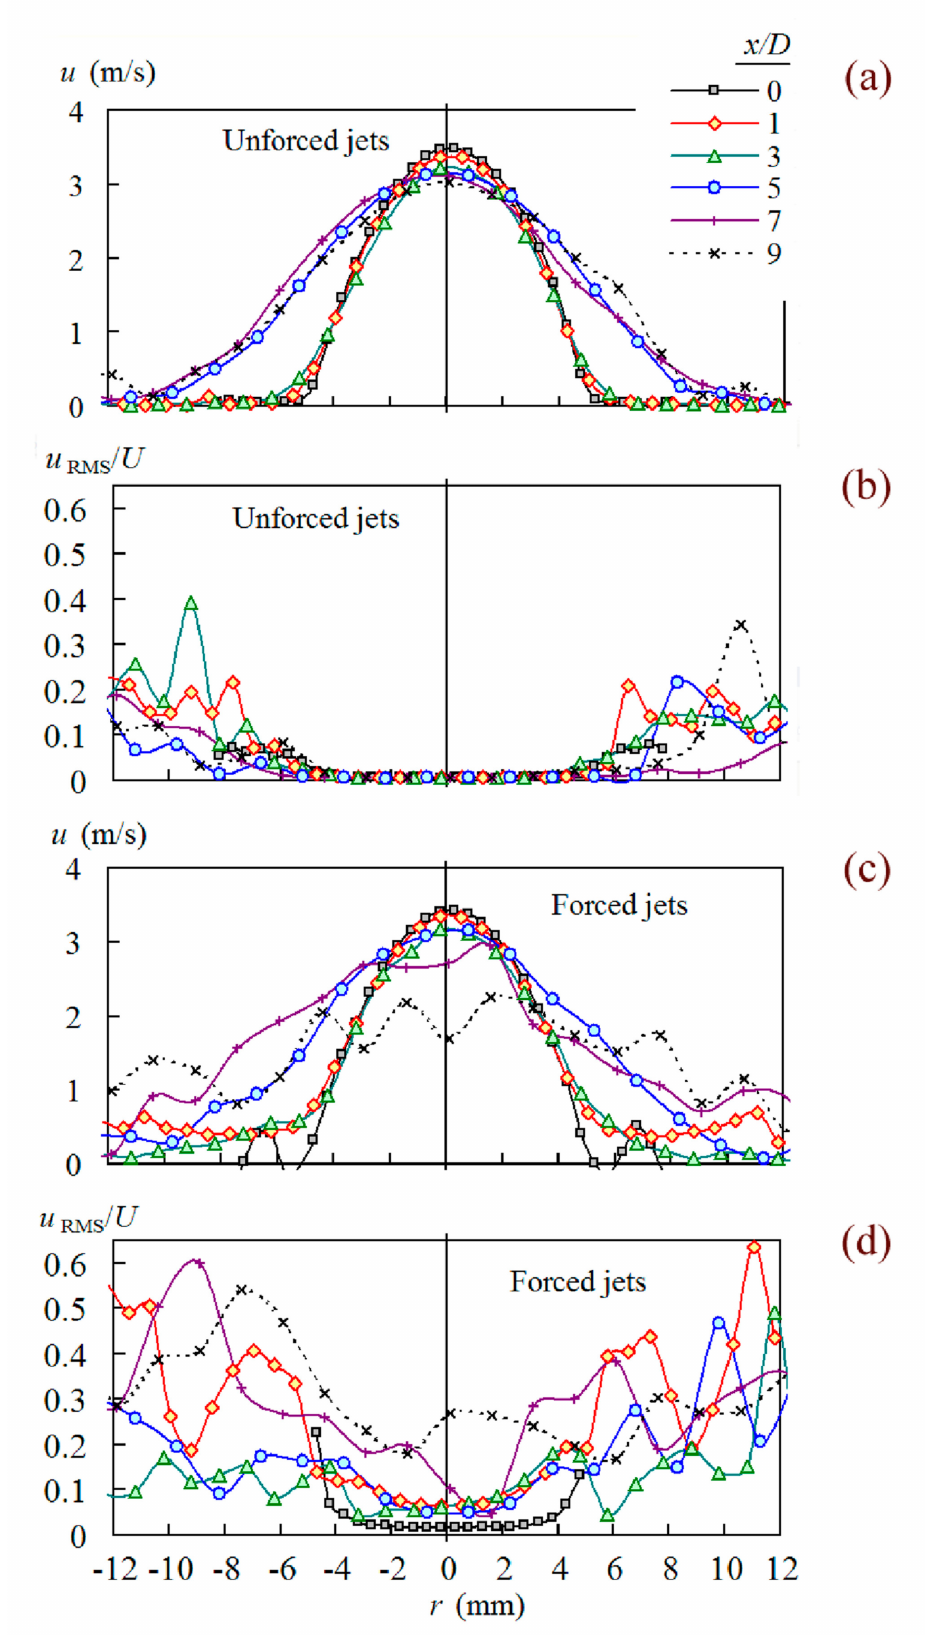
Figure 8. Radial profiles of time-mean velocity components and turbulence intensities at Re = 1082 for ( a , b ) unforced jets and ( c , d ) forced jets; ( a , c ) time-mean velocity components; ( b , d ) turbulence